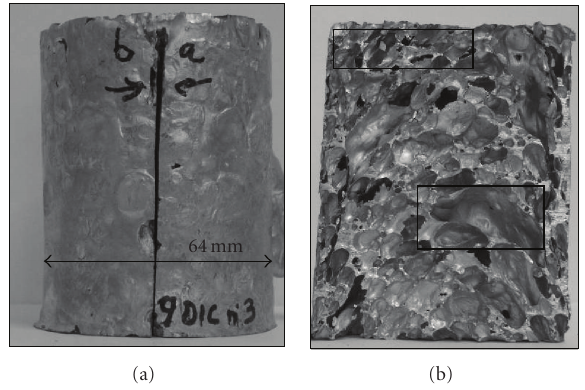
Figure 6: Cross section of an irregular cellular structure (SM, air,